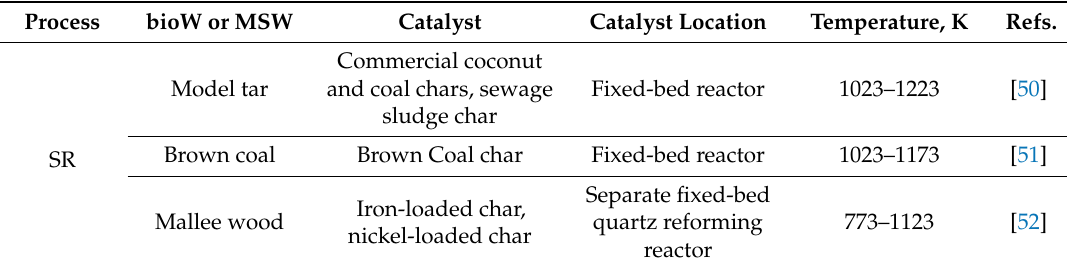
Table 1. T Selected research studies of catalytic MSW/biomass processing under different reaction conditions (SR-steam reforming, DR-dry